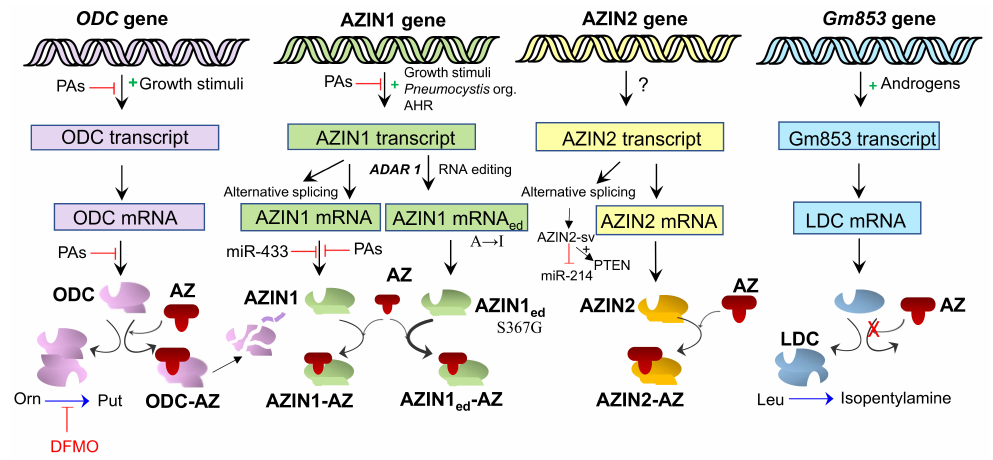
Figure 2. Scheme on the expression of ODC and its paralogues. The transcription of ODC and AZIN1 is up-regulated by different growth stimuli and down-regulated by polyamines (PAs). Translation of ODC mRNA is down-regulated by PAs and ODC activity and stability are decreased by AZ at the post-translational level. ODC activity is inhibited by α -difluoromethyl ornithine (DFMO). AZIN1 mRNA translation is inhibited by PAs and miR-433. PAs also affect AZIN1 splicing, and an edited form of AZIN1 with substitution of Ser367 by Gly has a higher affinity for AZ than AZIN1. AZIN2-sv is an lncRNA that interacts with miR-214 and activates phosphatase and tensin homolog (PTEN) . Gm853 is a paralogous gene of ODC and AZINs, that does not interact with AZs and that catalyses the decarboxylation of L -leucine to produce isopentylamine (See Section 3.5). AHR: aryl hydrocarbon receptor; AZ: antizyme; LDC: leucine